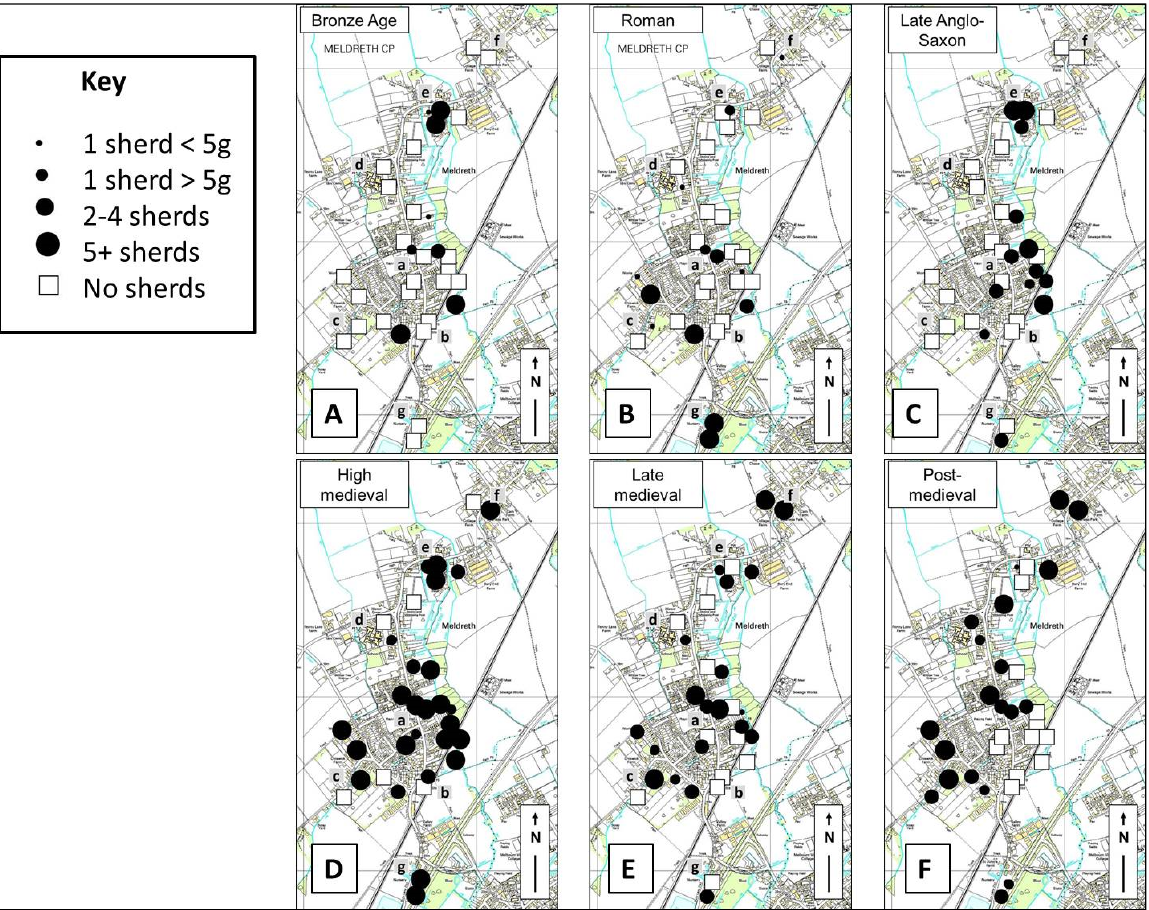
Figure 2. Pottery from test pits excavated in Meldreth. (A) Bronze Age; (B) Roman; (C) Late Anglo-Saxon; (D) High medieval; (E) Late medieval; and (F)